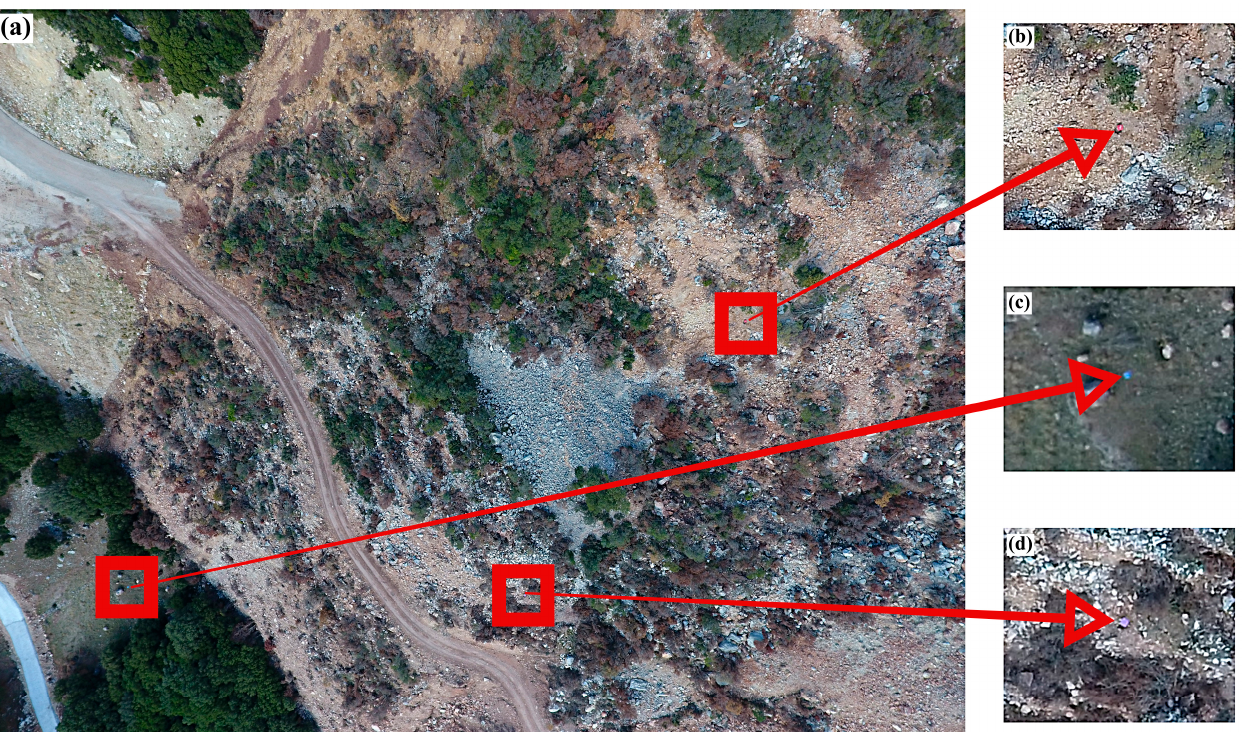
Figure 3. ( a ) UAV image acquired on 5 November 2017. The red squares define the area where GCPs are located. ( b – d ) GCP patterns as recognized in UAV imagery.